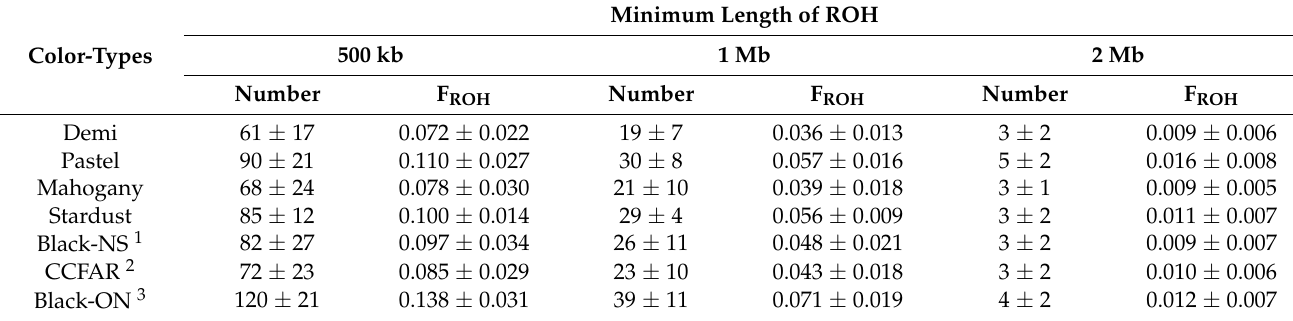
Table 2. The average ( ± SD) number of runs of homozygosity (ROH) and inbreeding rates based on ROH (F ROH ) in different color-types of American